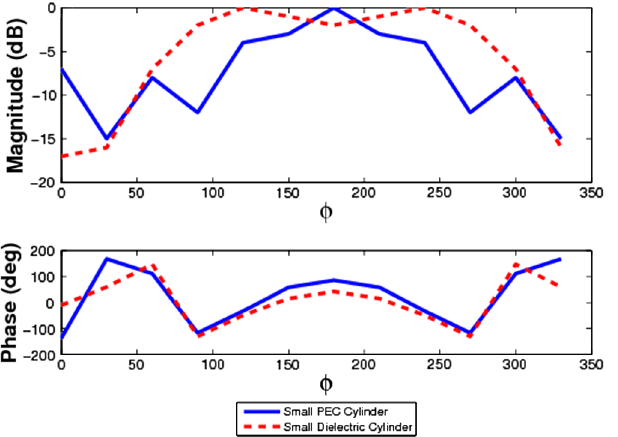
FIG. 10. The magnitude and phase of the magnetic currents required to disguise a PEC cylinder. The blue curves show the required magnetic currents for disguising the PEC cylinder as a smaller PEC cylinder. The red curves show the required magnetic currentsfordisguisingaPECcylinderasasmallerdielectriccylinder.